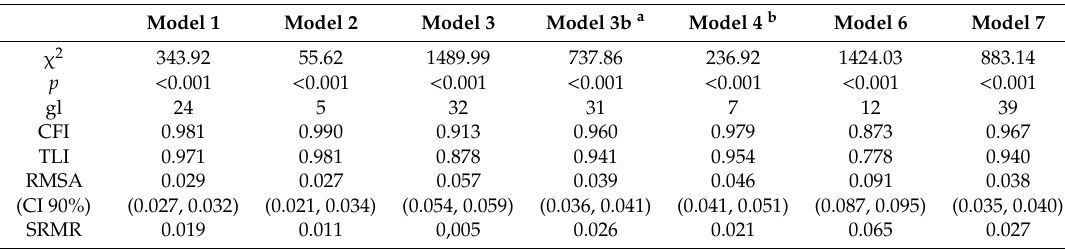
Table 5. Goodness-of-fit indices for all proposed